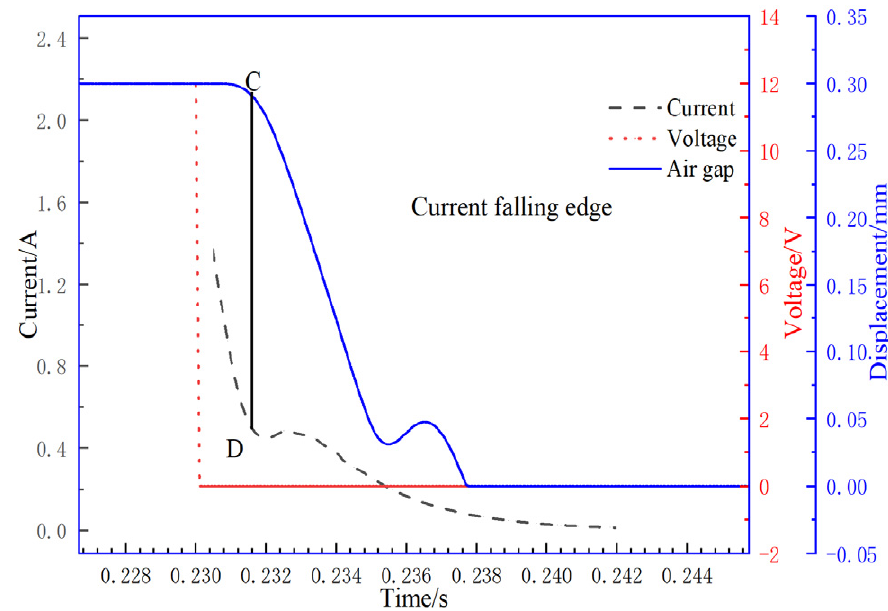
Figure 10. Response curve of current falling edge.